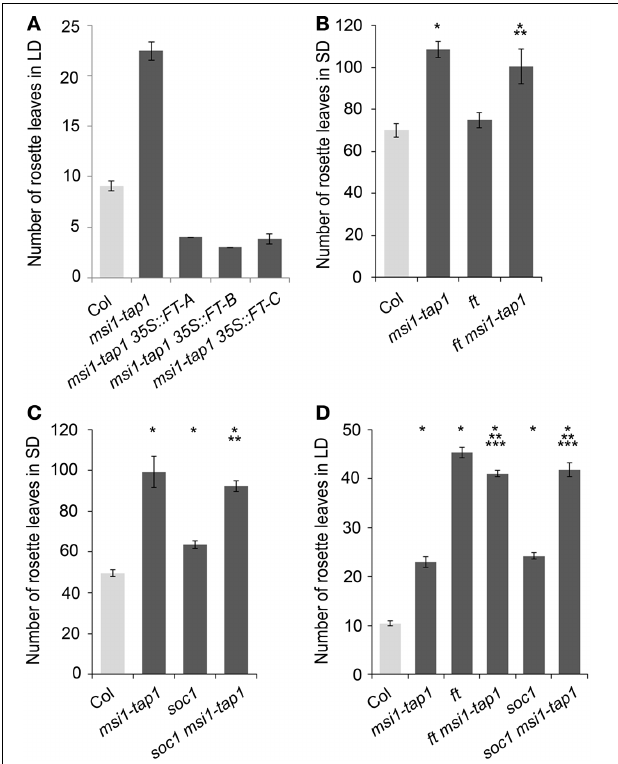
FIGURE 2 | Flowering time analysis of msi1-tap1 and double mutants. (A) Flowering time of Col, msi1-tap1 and msi1-tap1 35S::FT lines in LD. The 35S::FT suppresses the late flowering of msi1-tap1 . (B) Flowering time of Col, msi1-tap1, ft, and ft msi1-tap1 in SD. (C) Flowering time of Col, msi1-tap1, soc1 , and soc1msi1-tap1 in SD. (D) Flowering time of Col, msi1-tap1, ft, ft msi1-tap1, soc1 and soc1msi1-tap1 in LD. Light gray bars represent wild type Col. Shown are means ± SE of rosette leaves ( n ≥ 14). Significance of difference was tested using t -tests. Asterisks denote differences that were significant at p < 0 . 05 to WT ( ∗ ), single mutant ( ∗∗ ), or msi1-tap1 ( ∗∗∗